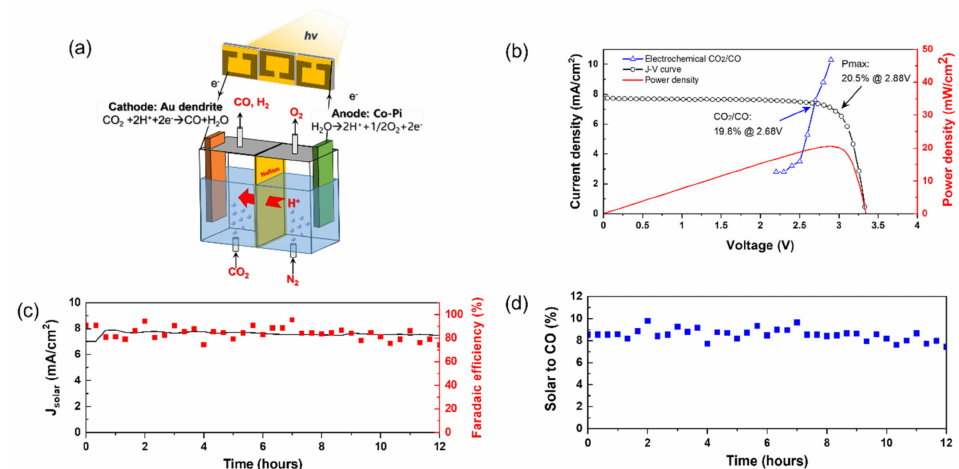
Figure 3. Performance of PV integrated CO 2 reduction system. ( a ) Schematic illustration of PV inte- grated CO 2 reduction and water oxidation system. ( b ) J–V curves of three series-connected perovskite cells under simulated AM 1.5G 1 Sun solar irradiation (black dots), overlaid with the matched J–V characteristic of the CO 2 -reduction and water oxidation electrodes (blue dots). ( c ) Current density (black line), faradaic efficiency of CO (red dots), and ( d ) solar-to-CO conversion efficiency (blue dots) of the device during a 12-h stability